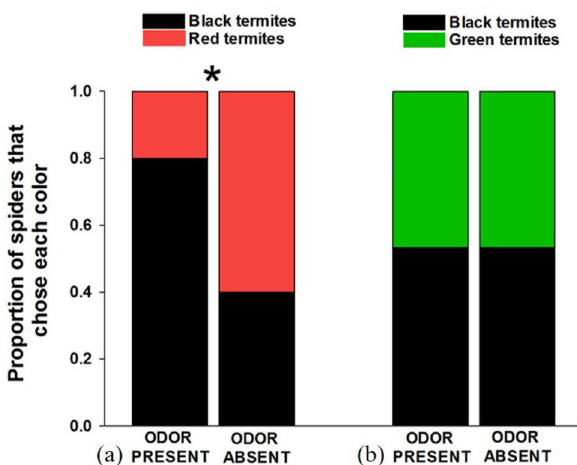
Figure 3. Results of choice tests between ( a ) red- and black-painted termites, and ( b ) green- and black-painted termites in the presence or absence of a defensive odor from grass stinkbugs ( Mormidea pama ).